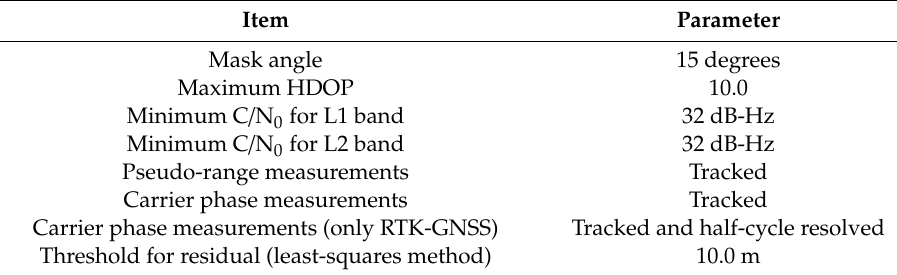
Table 4. Common parameters for satellite